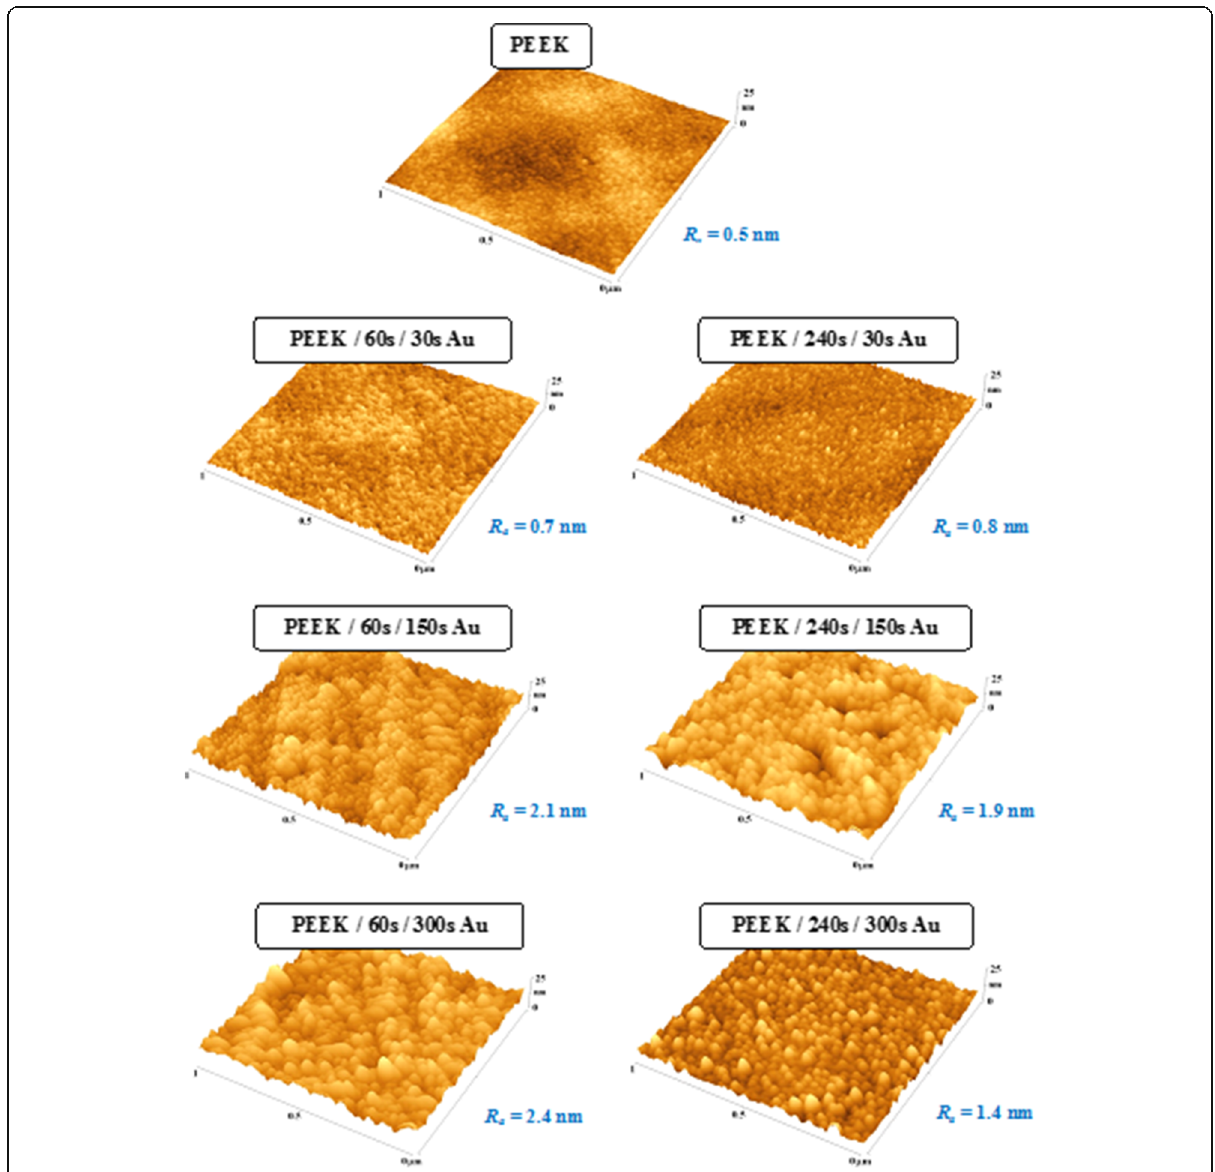
Fig. 1 AFM images of pristine PEEK, PEEK treated by plasma (pl) for 60 and 240 s, and gold (Au) sputtered for 30, 150, and 300